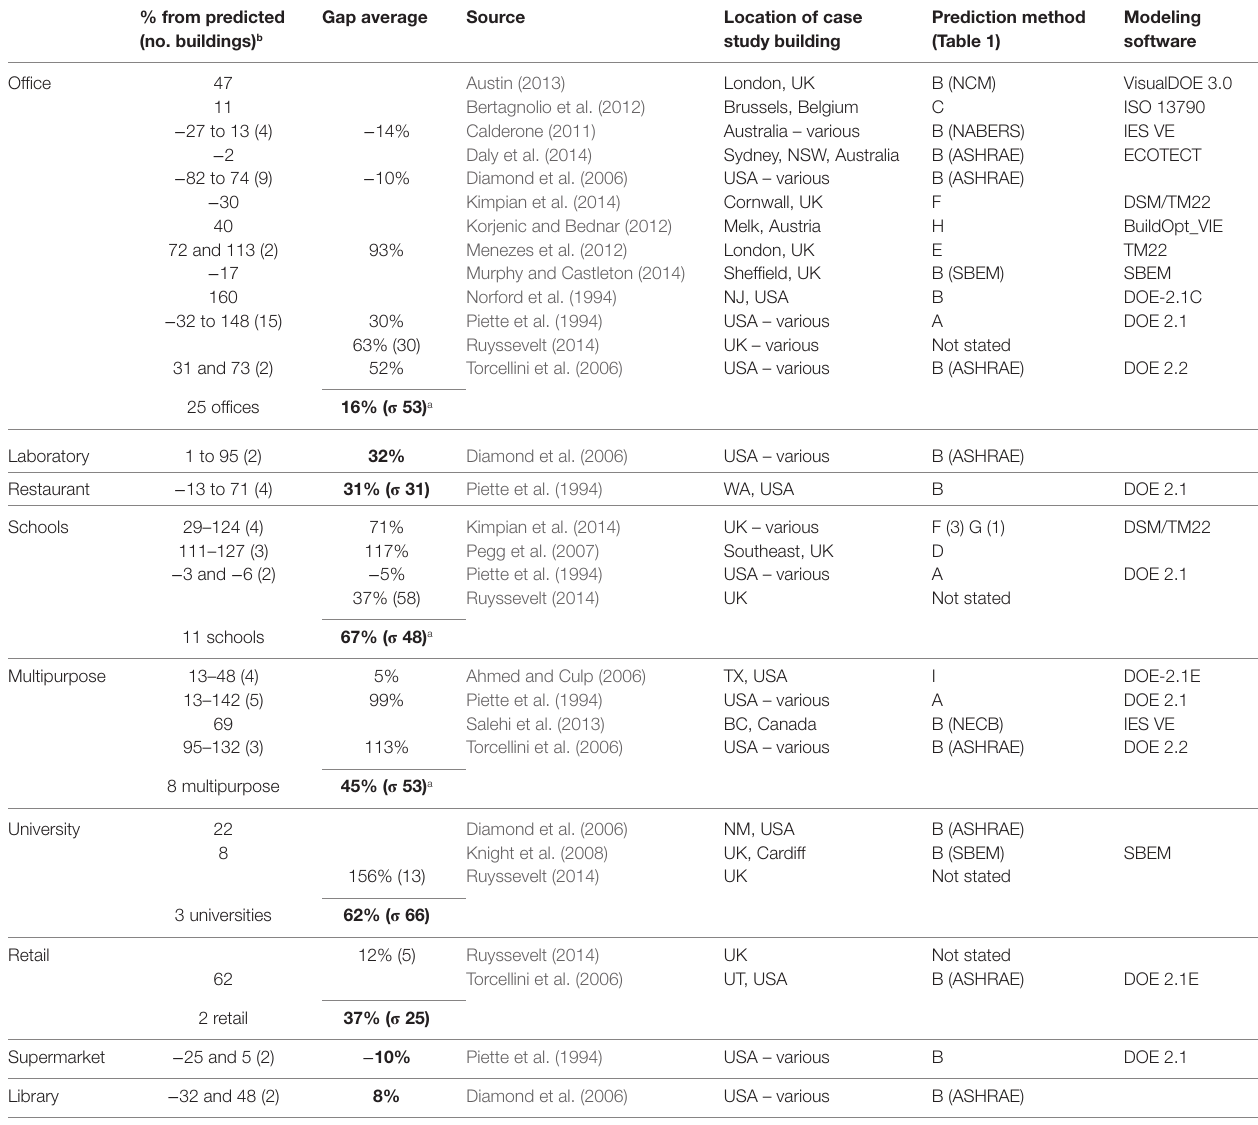
TABLe 1 | Magnitude in discrepancy reported in the literature (regulatory performance gap including equipment energy use). % from predicted (no. buildings)